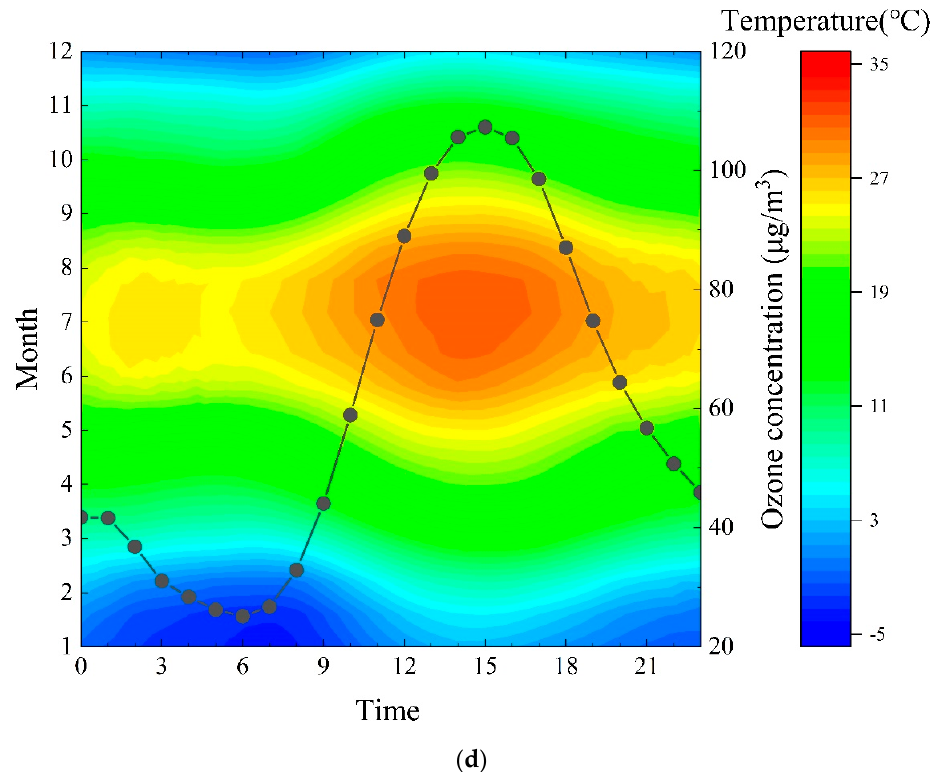
Figure 7. Air temperature and ozone concentrations for typical coastal and inland cities of Shandong province in 2018 (( a ) WH; ( b ) YT; ( c ) JNA; ( d ) LY).